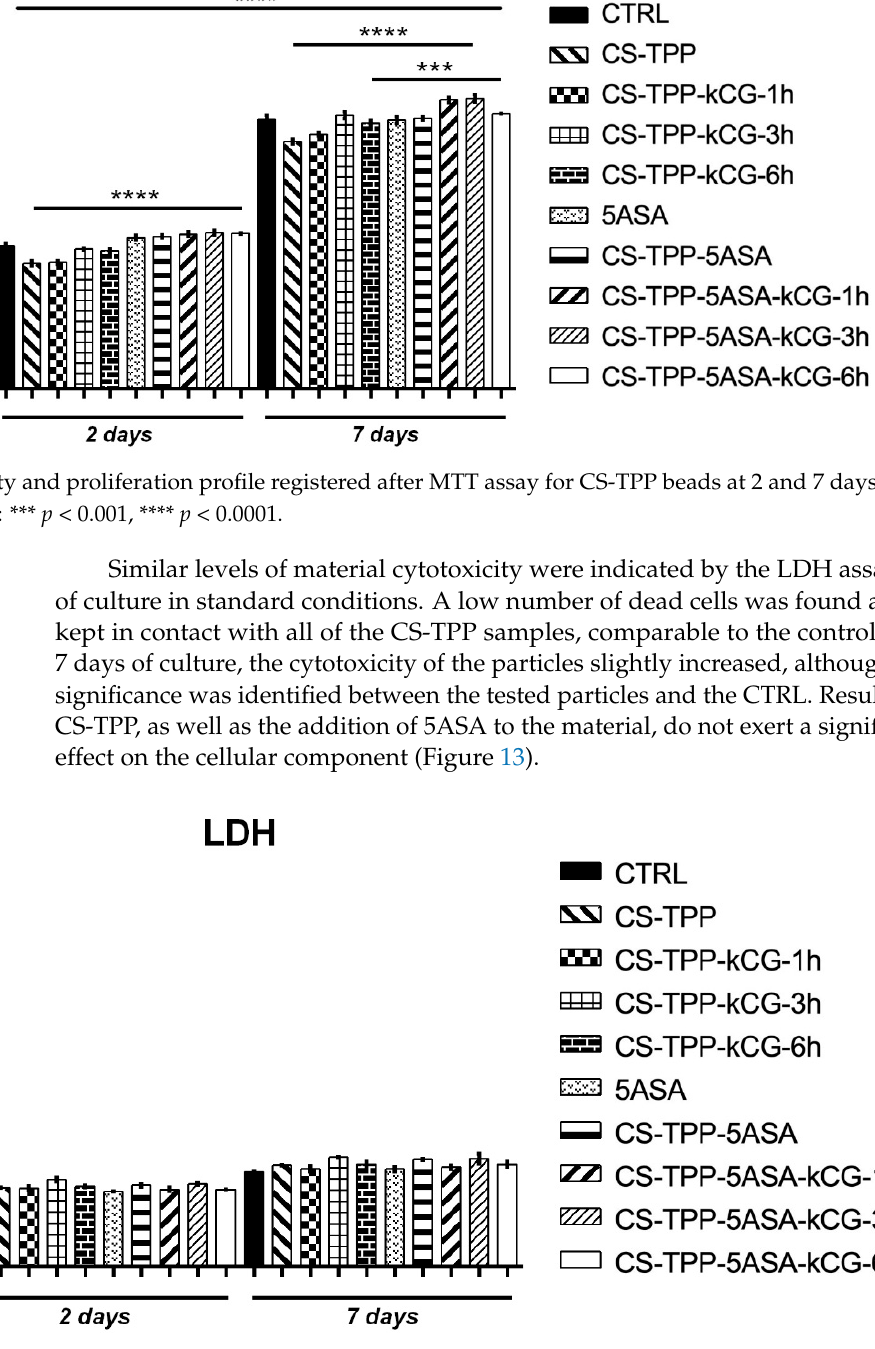
Figure 13. Cytotoxic effect level registered after LDH assay for CS-TPP beads after 2 and 7 days of culture.